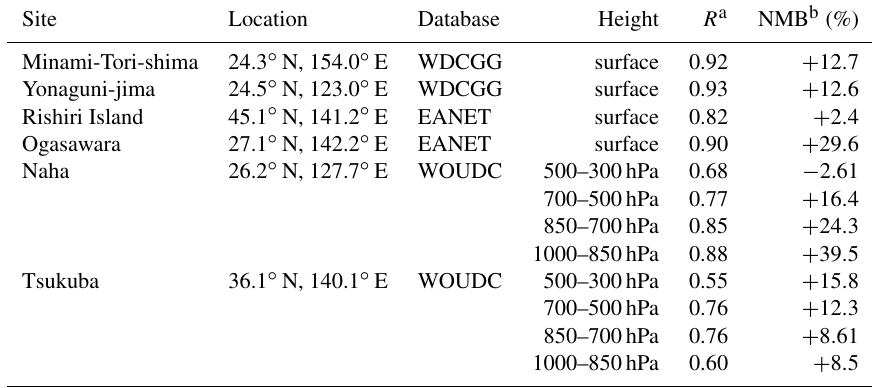
Table 4. Information for the sites with O 3 measurements used in the model